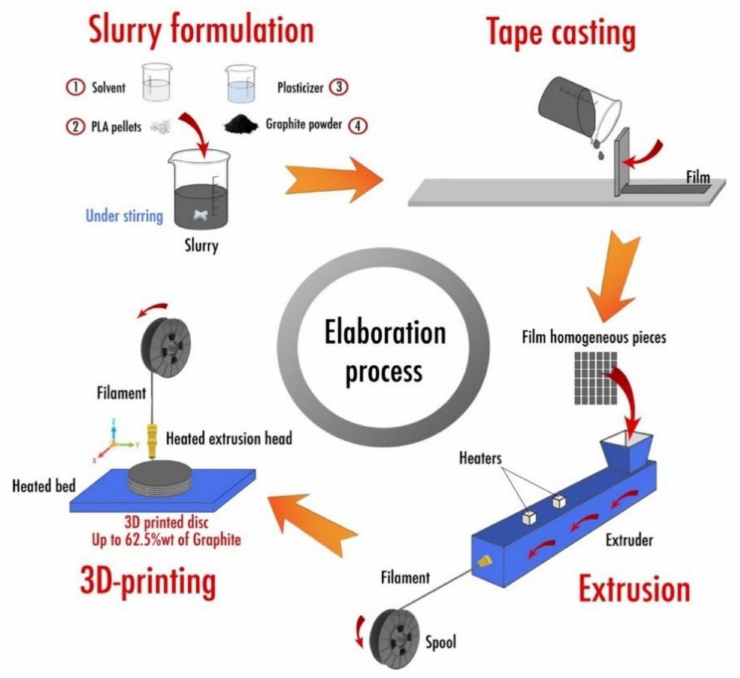
Figure 17. Main steps of the 3D-printed negative electrode disc elaboration process (Reproduced with permission from Reference [161], copyright 2018, American Chemical